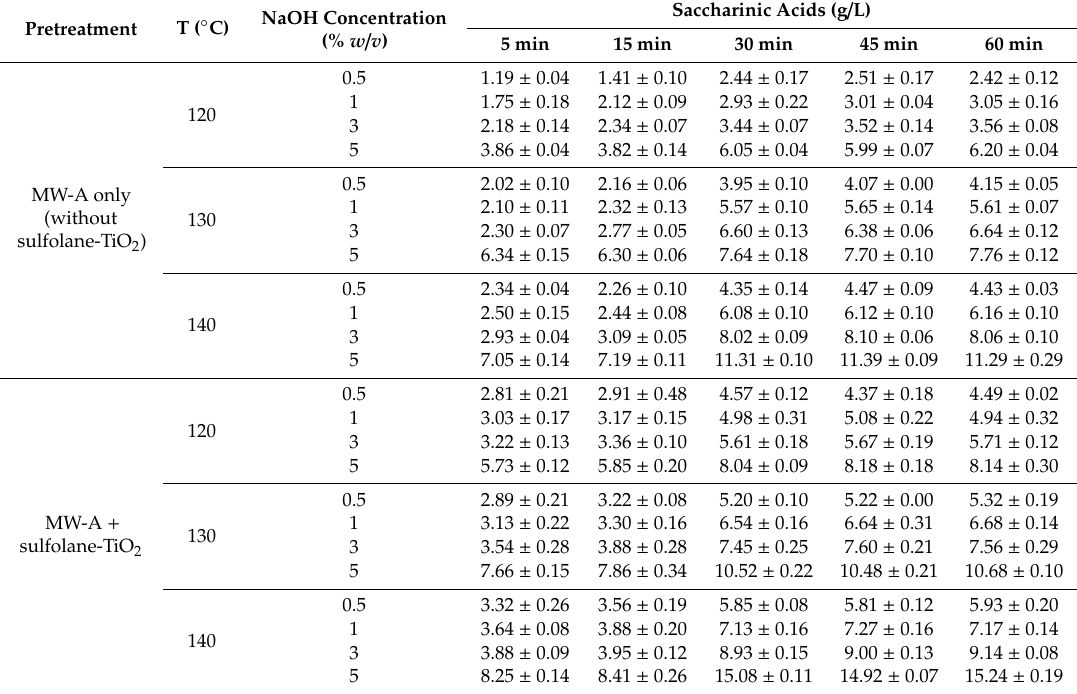
Table 3. Saccharinic acids production from enzymatic hydrolysis of SCB for di ff erent temperatures, NaOH concentrations and reaction times, with and without sulfolane-TiO 2 .